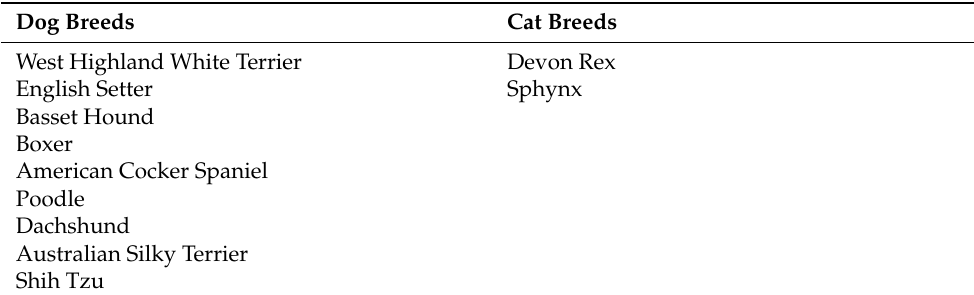
Table 2. Breed predisposition for Malassezia dermatitis in companion